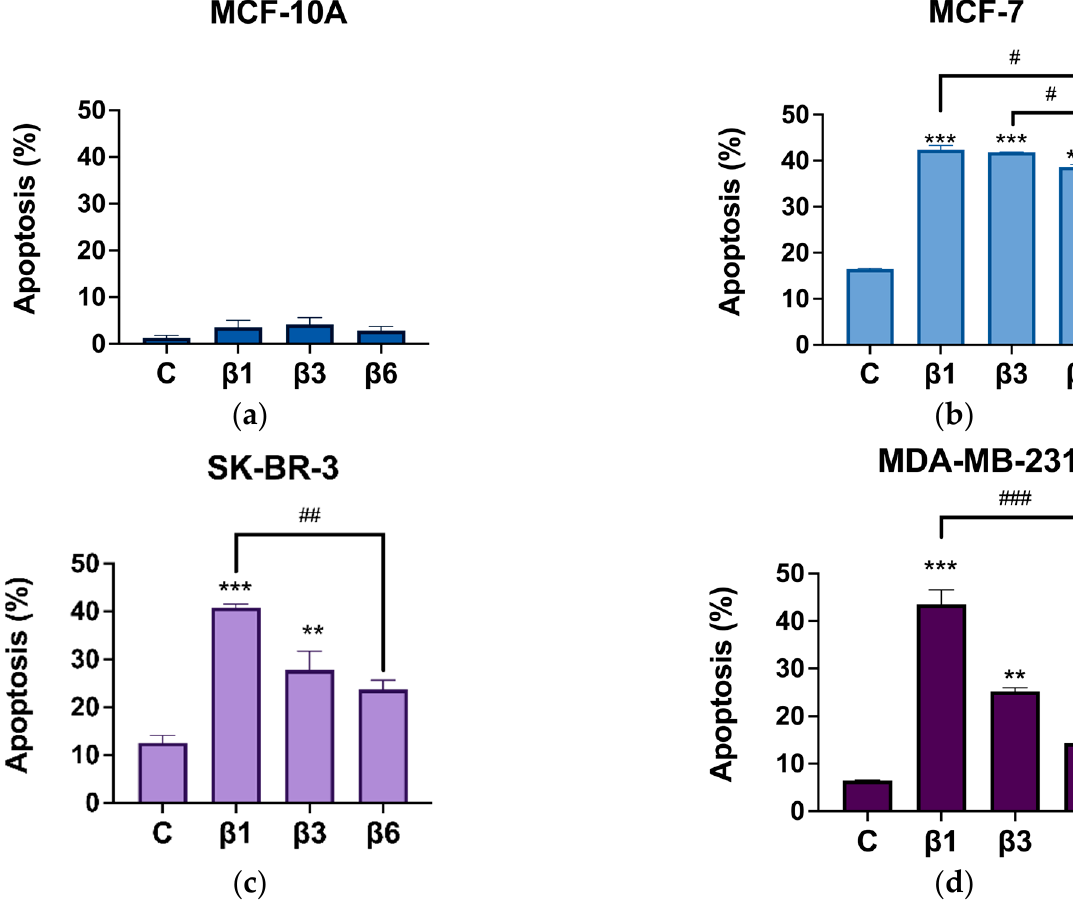
Figure 2. Percentage of apoptotic cells after treatment with β 1-conglutin (2.5 ng/µL) β 3-conglutin (5 ng/µL) or β 6-conglutin (10 ng/µL) for 24 h in ( a ) MCF-10A, ( b ) MCF-7, ( c ) SK-BR-3, and ( d ) MDA- MB-321. After 24 h of ( a ) β 1, ( b ) β 3, and ( c ) β 6-conglutin treatment, cells were trypsinized, washed, and incubated for 15 min with both AnnexinV-FITC and Propidium Iodide from the IP-Annexin V kit (BD Biosciences, UK). Apoptosis was calculated with both early and late apoptotic cells. Samples were immediately analyzed using the BD FACS Aria IIIu Flow Cytometer (Becton Dickinson, BD Bioscience). * p < 0.05, ** p < 0.01, and *** p < 0.001 vs. non-treated cells, and # p < 0.05, ## p < 0.01, and ### p < 0.001 vs. other treatments.